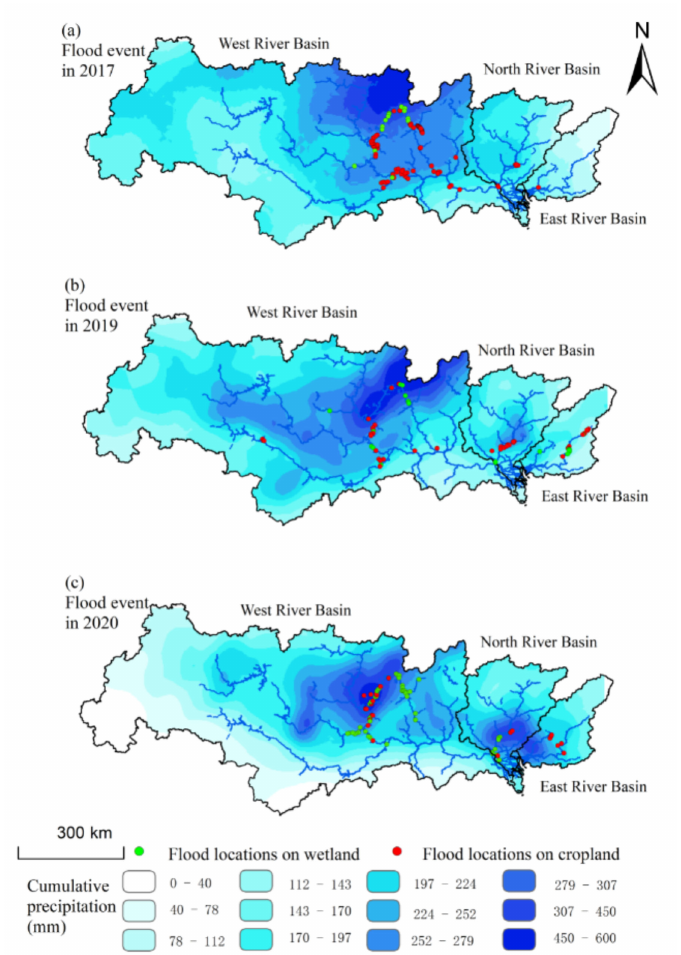
Figure 6. ( a ) Flood event in 2017 in PRB; ( b ) Flood event in 2019 in PRB; ( c ) Flood event in 2020 in PRB. Corresponding flood periods are shown in Table